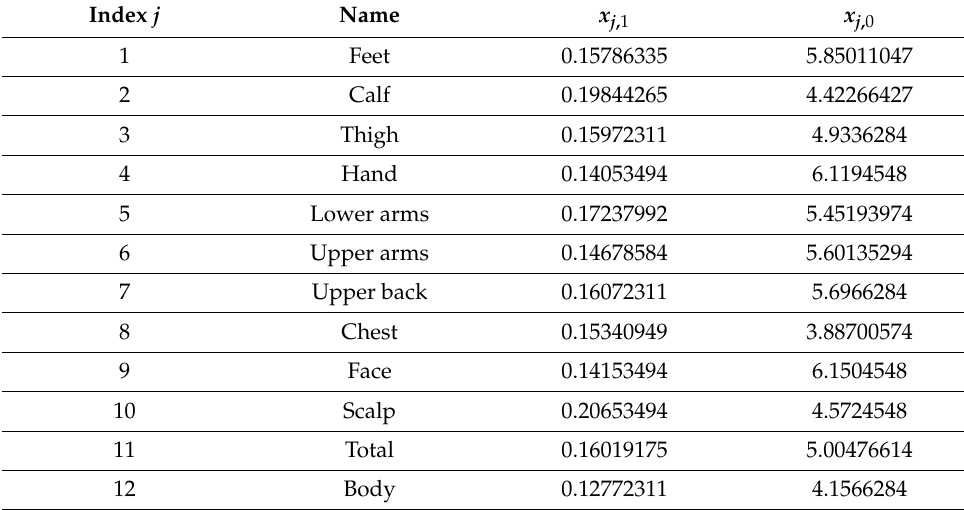
Table 4. Linear approximation coefficients for h eq .